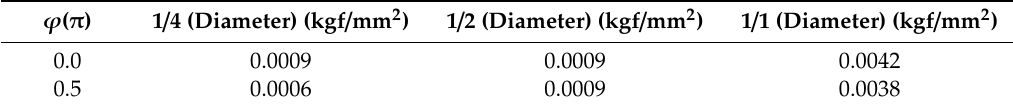
Figure 7. Birefringence distribution of SiO 2 film after doping with GeH 4 gas. Table 1. Measured values of birefringence for the wafer.